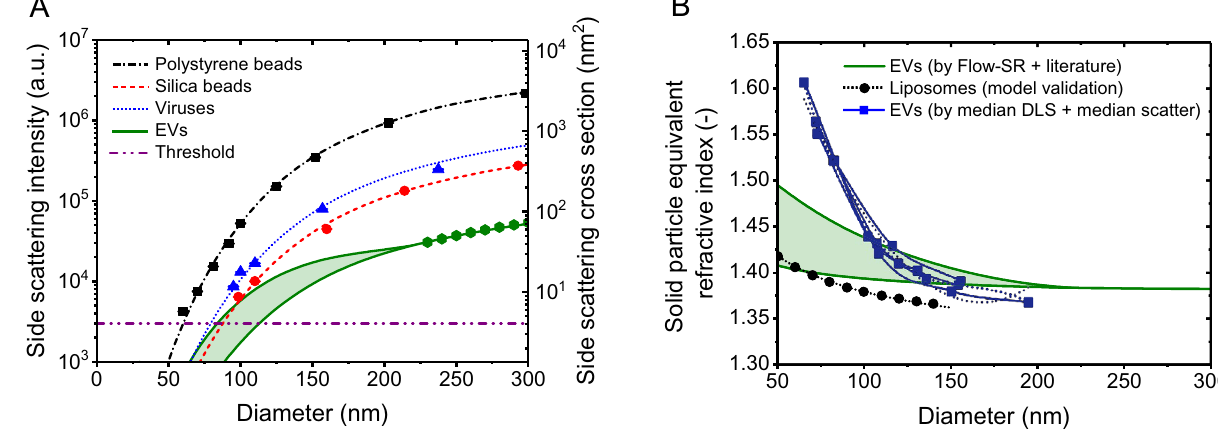
Figure 1. ( A ) Side scattering intensity measured (symbols) by a CytoFLEX 1 and calculated (lines) by Mie theory 10 versus diameter for polystyrene beads (squares), silica beads (circles), viruses (triangles), and CD61 + EVs (hexagons). The assumed refractive index (RI) is 1.627 for polystyrene beads, 1.440 for silica beads, and 1.472 for viruses at the illumination wavelength of 405 nm. EVs were modelled as core–shell particles, having a 12 nm thick shell with an RI of 1.52 and a core RI of 1.353 (upper solid line), and having a 4 nm thick shell with an RI of 1.450 and a core RI of 1.380 (lower solid line). The horizontal line indicates the trigger threshold. ( B ) Solid particle equivalent RI versus diameter for plasma-derived EVs based on Flow-SR 11 and literature (panel A, solid green lines), for liposomes 19 (dotted line), and for plasma-derived EVs based on the dynamic light scattering (DLS) measurements and the flow cytometry light scattering measurements performed by Brittain et al. 1 (overlapping blue lines and symbols). Below a diameter of 100 nm, the solid particle equivalent RI based on DLS and flow cytometry light scattering is substantially higher compared to estimates based on Flow-SR 11 and literature and liposome